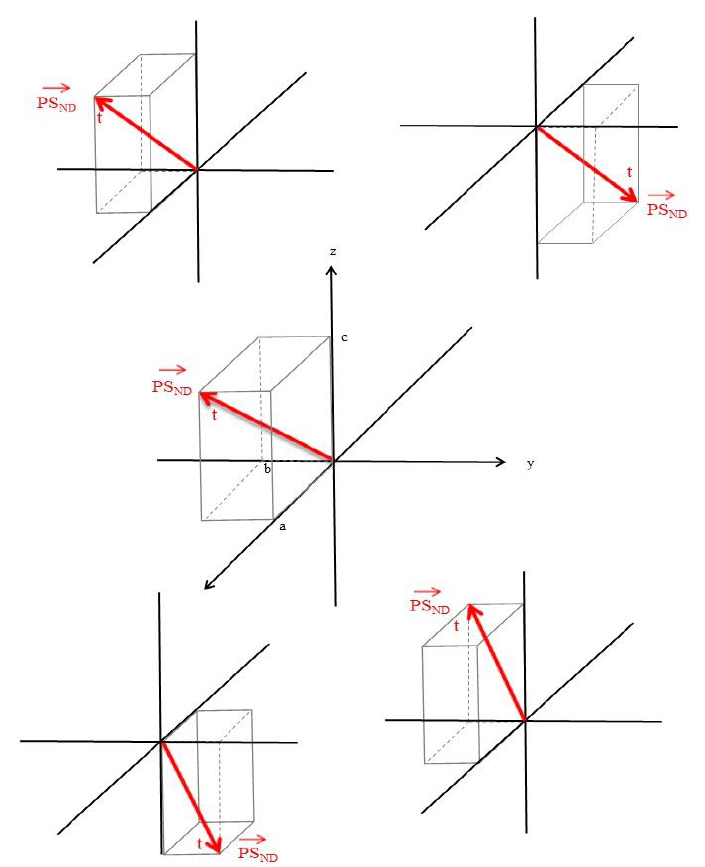
Figure 2. The trajectories of multiple protein sequences (PS) in space and time in neurodegeneration. PS ND = protein sequence, neurodegeneration.